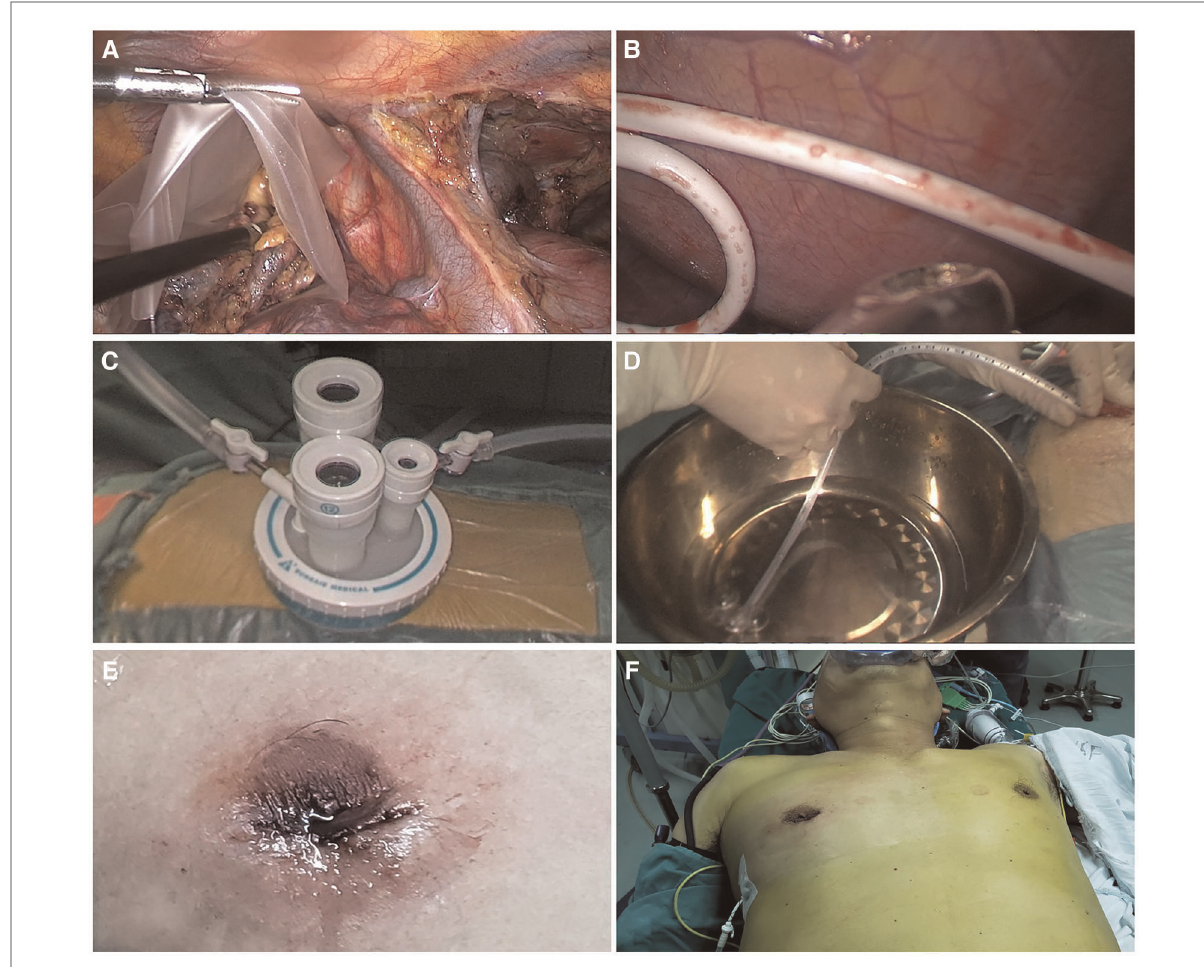
FIGURE 4 ( A ) placement of specimens in a plastic bag. ( B ) Placement of a 2-mm subclavian vein tube through the sixth intercostal space at the midaxillary line. ( C ) Uniportal wound protector. ( D ) Ventilation and exertion of continuous positive pressure for a few seconds. ( E,F ) Postoperative view of transareolar uniportal